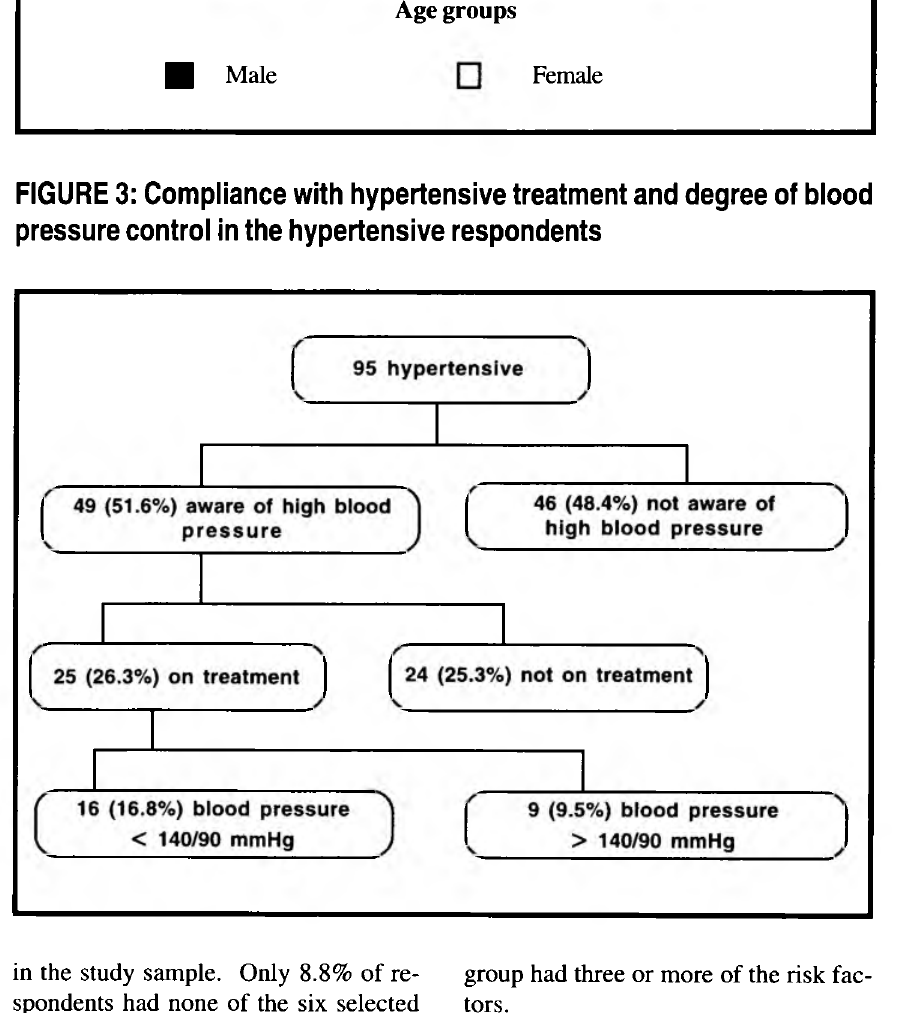
FIGURE 3: Compliance with hypertensive treatment and degree of blood pressure control in the hypertensive